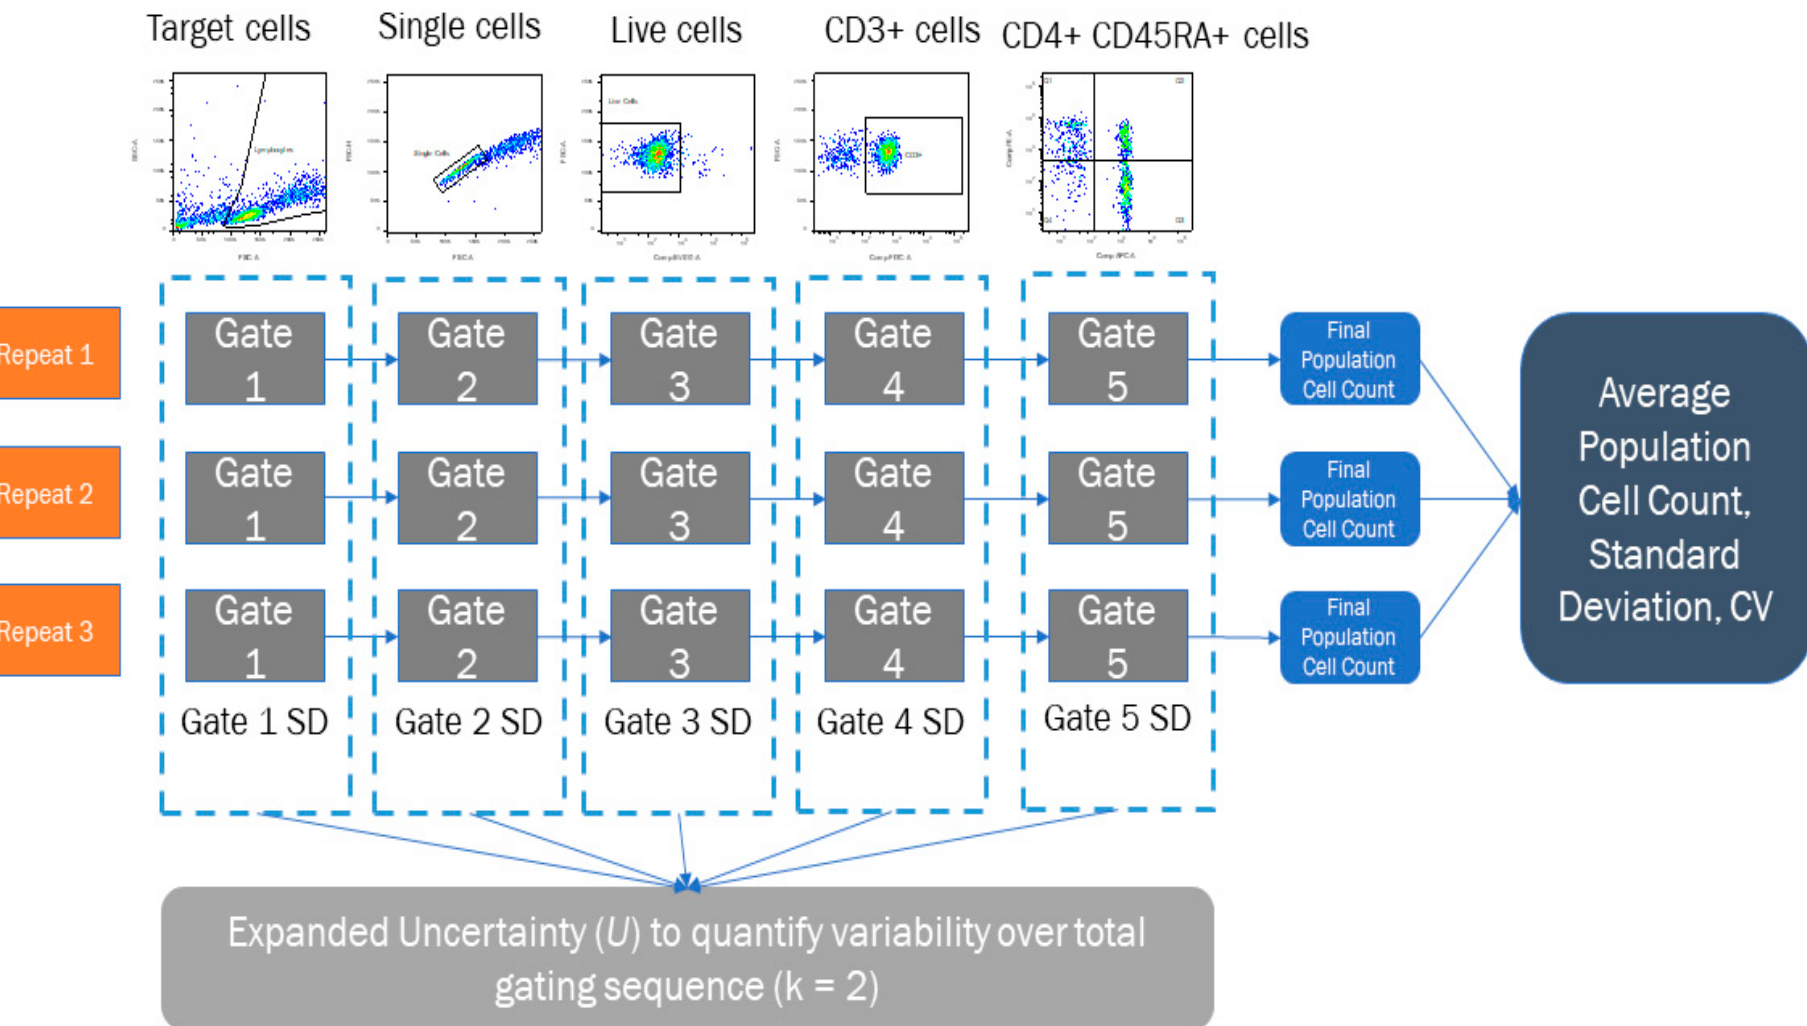
Figure 2. Processing sequence for participant studies to calculate average cell counts, SDs and CVs across three repeats, as well as the Expanded Uncertainty from SD of each of the individual gate repeats (dashed line).